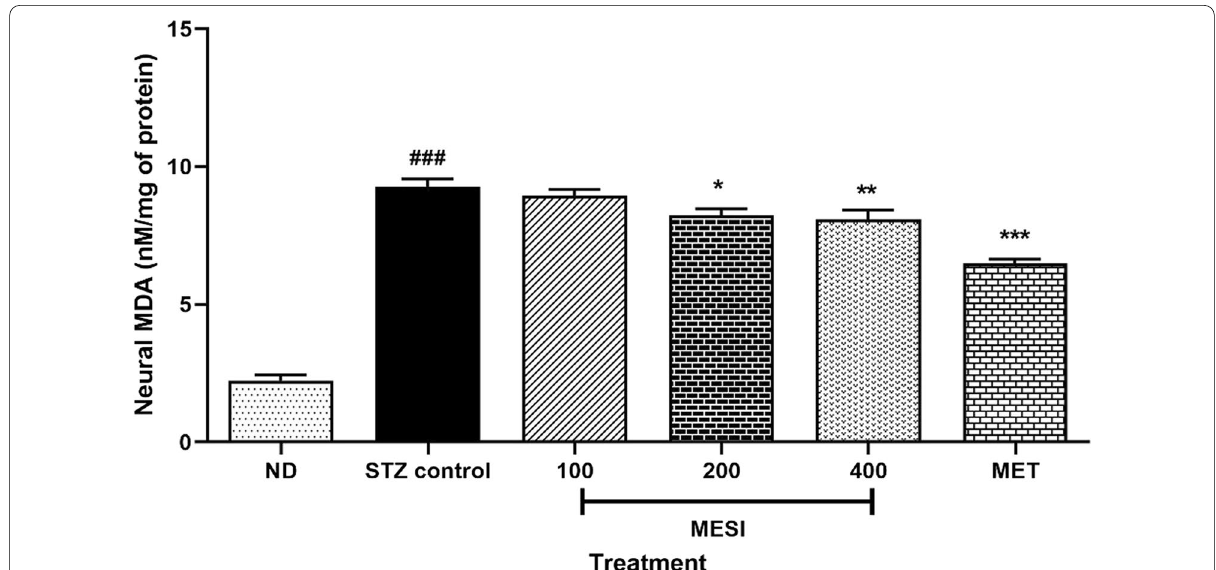
Fig. 5 Effect of MESI on diabetes-induced alteration in the index of lipid peroxidation (LPO). Data are expressed as mean analyzed by one-way ANOVA followed by a post hoc Tukey’s multiple range test. *P < 0.05, **P < 0.01 for MESI, and *** P < 0.001 for metformin-treated groups compared to the diabetic (STZ) control group. ### P < 0.001 for the diabetic (STZ) control group compared to the normal non-diabetic group.